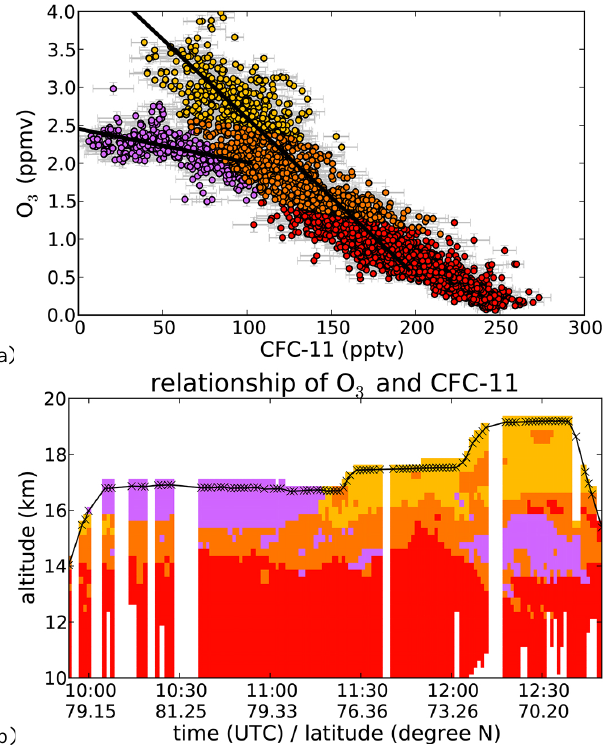
Fig. 4. Relationship between CFC-11 and O 3 for retrieved trace gas VMRs. Panel (a) shows a scatter plot for all measured air parcels with two black lines corresponding to typical correlations for vortex and non-vortex air. Purple parcels are thus categorised as vortex air, while yellow and red parcels consist of non-vortex air. Orange parcels cannot be clearly distinguished according to this criterion. The error bars show the precision of the measurements. Panel (b) shows the geo-spatial distribution of the same air parcels using the same